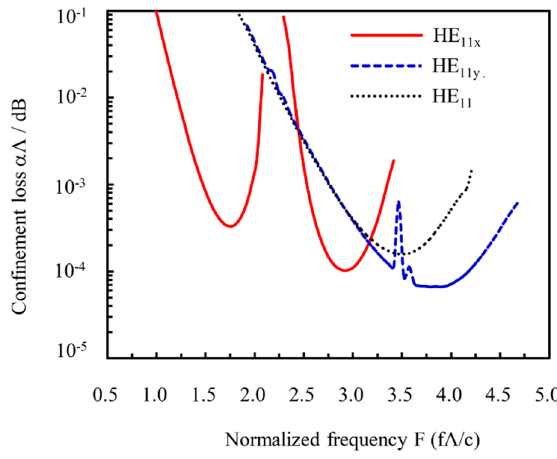
Figure 5. Confinement losses for degenerate fundamental mode HE 11 (without an external electric field across the fiber) and polarized fundamental modes HE 11x and HE 11y (with an external electric field applied along the x-axis).